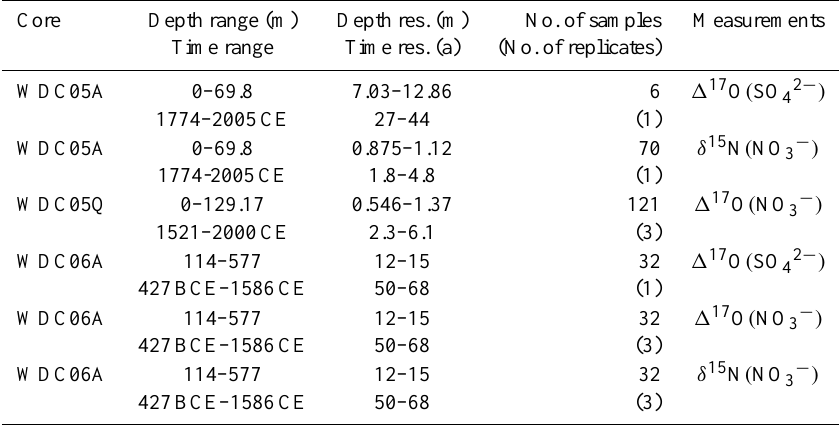
Table 1. Ice core sampling resolution and isotopic measurements. Core